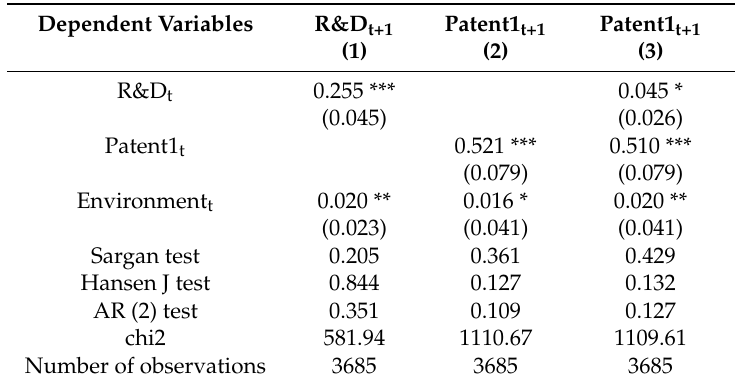
Table 8. System GMM estimation